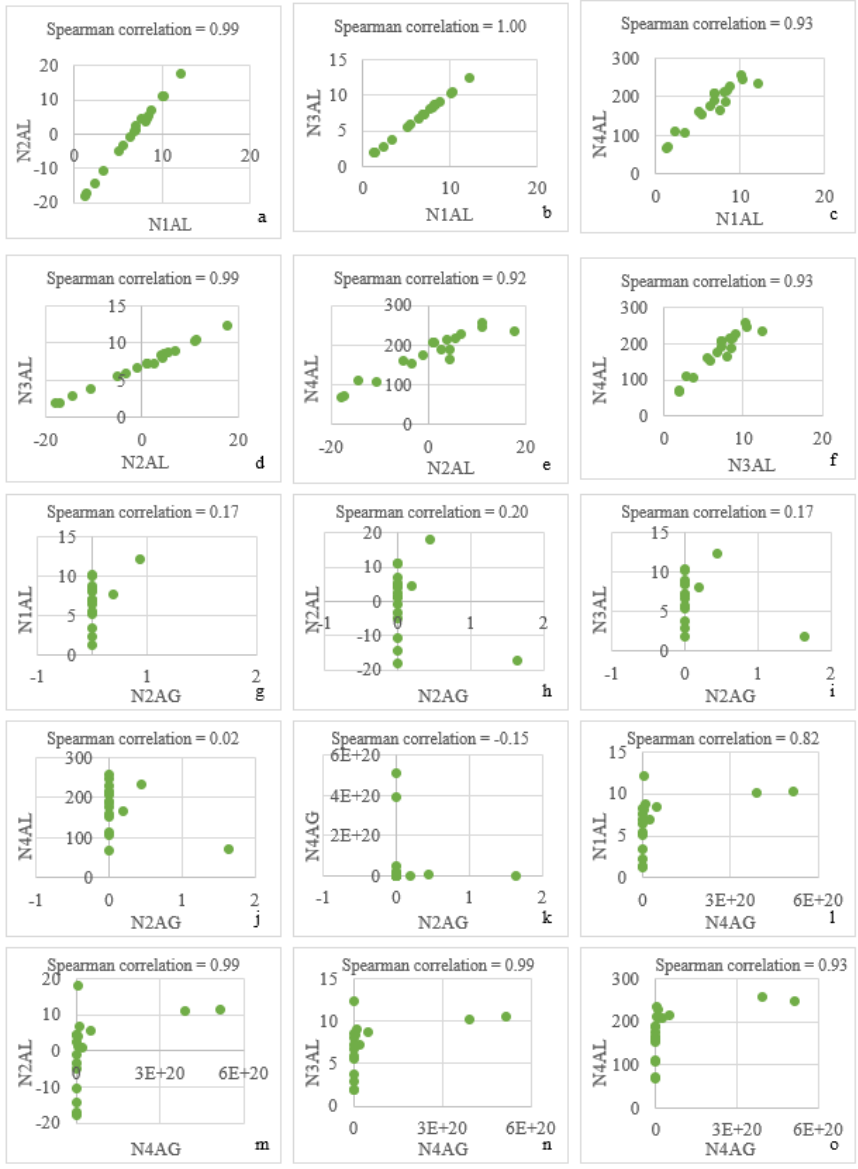
Figure 4. Correlations between the flood vulnerability indexes of normalization and aggregation methods. N1 = Min-max normalization, N2 = Z-scores normalization, N3 = distance to target normalization, N4 = ranking normalization, AL = linear aggregation, and AG = geometric aggregation.